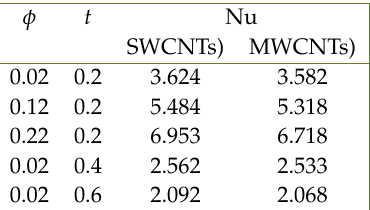
Table 3. Variant of skin friction for embedded parameters at Pr